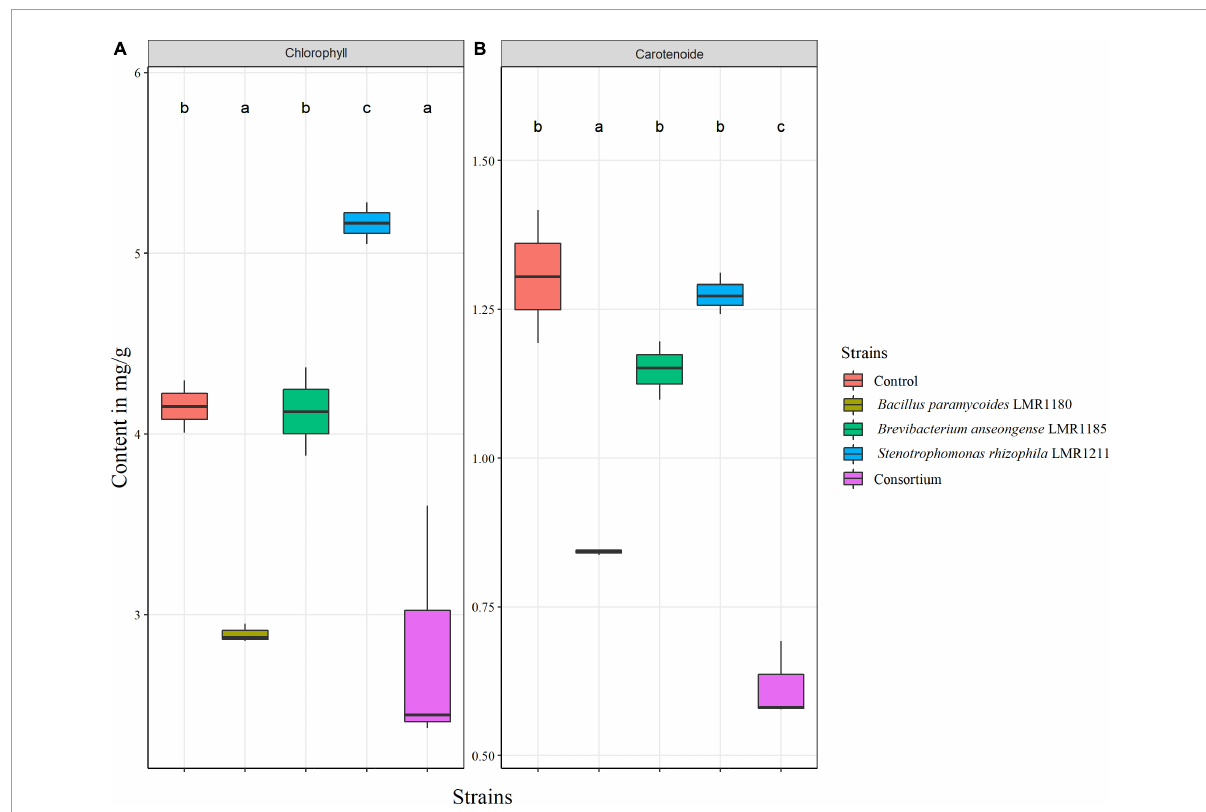
FIGURE6 The estimation of total chlorophyll (A) and carotenoid (B) content in control and inoculated Lupinus albus plants using the three selected strains ( Bacillus paramycoides LMR1180, Brevibacterium anseongense LMR1185, and Stenotrophomonas rhizophila LMR1211) in mg/g of biomass after 90 days under greenhouse conditions. The letters (a, b, and c) present the compact display letters (CDL). Values in each bar followed by the same letter are not significantly different at 0.05%